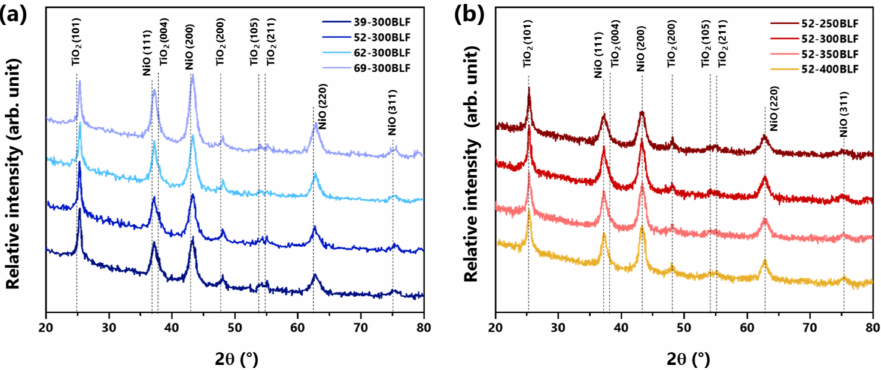
Figure 4. XRD patterns of BLFs at: ( a ) different NiO loadings calcined at 300 ◦ C and ( b ) different NiO calcination temperatures at 52%